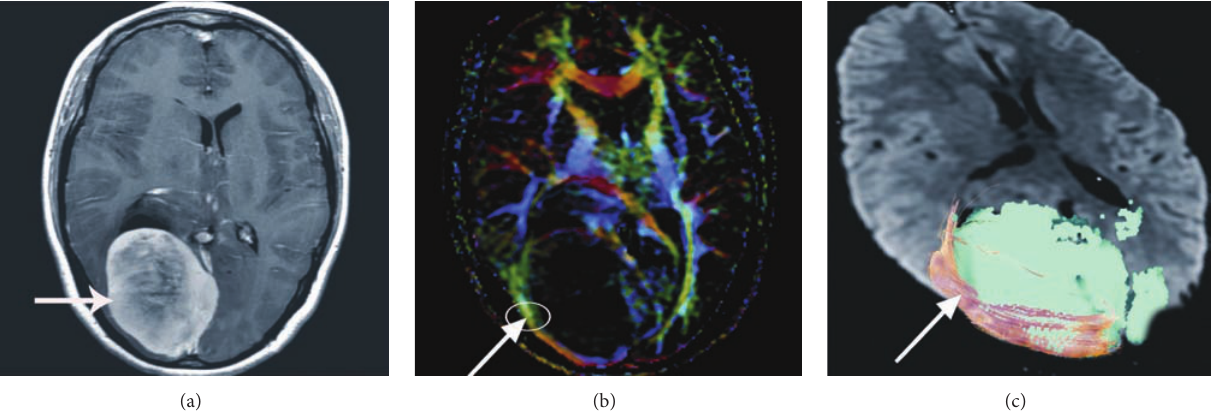
Figure 3: The contrast T 1 WI image of right occipital lobe meningioma in a 42-year-old woman ((a), arrow). The FA value of right GCT decreases mildly ((b), arrow). DTT map shows the right GCT fibers are displaced ((c),